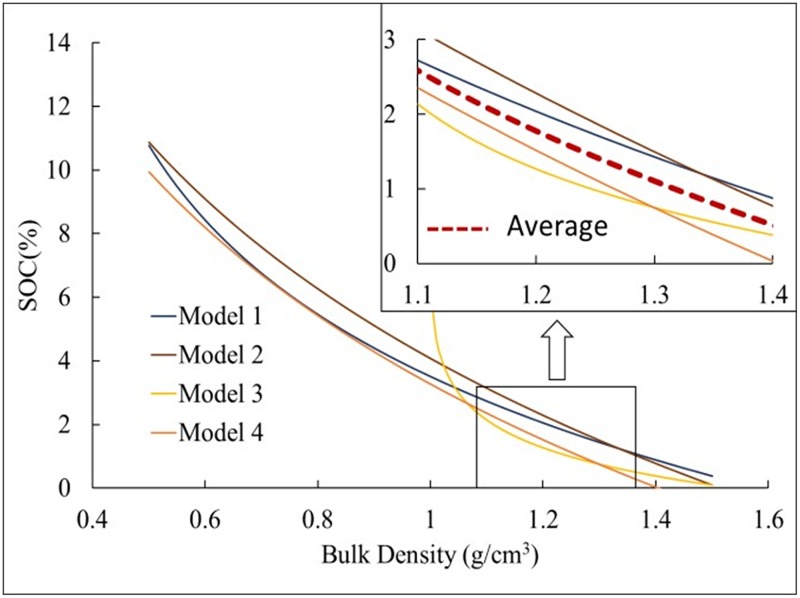
Model-simulated SOC based on bulk density for different models (Models1-4).